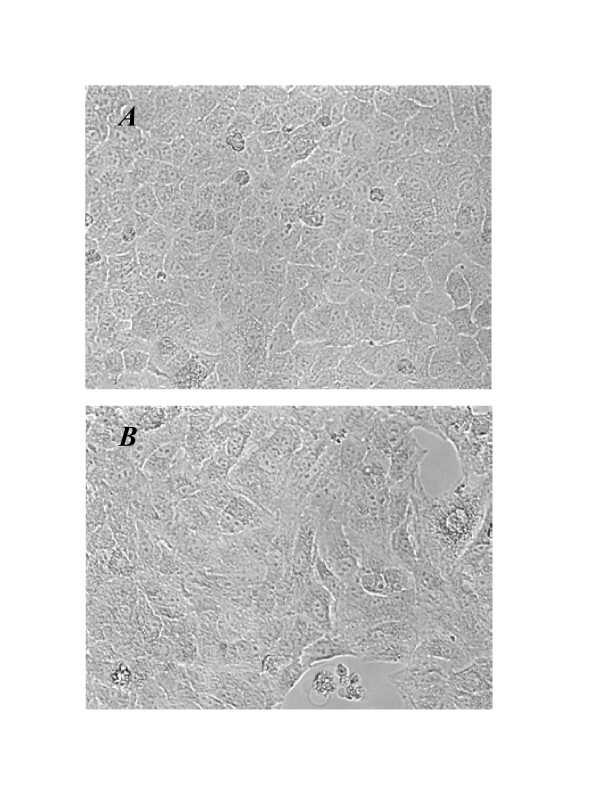
Morphological changes induced by TGF-β1. A549 cells were incubated with 5 ng/ml of TGF-β1 for 48 h. (A) Untreated A549 cells show a pebble-like shape and cell-cell adhesion is clearly observed. (B) TGF-β1-treated cells show a decrease in cell-cell contacts and adopt a more elongated morphological shape (magnification of 200×).